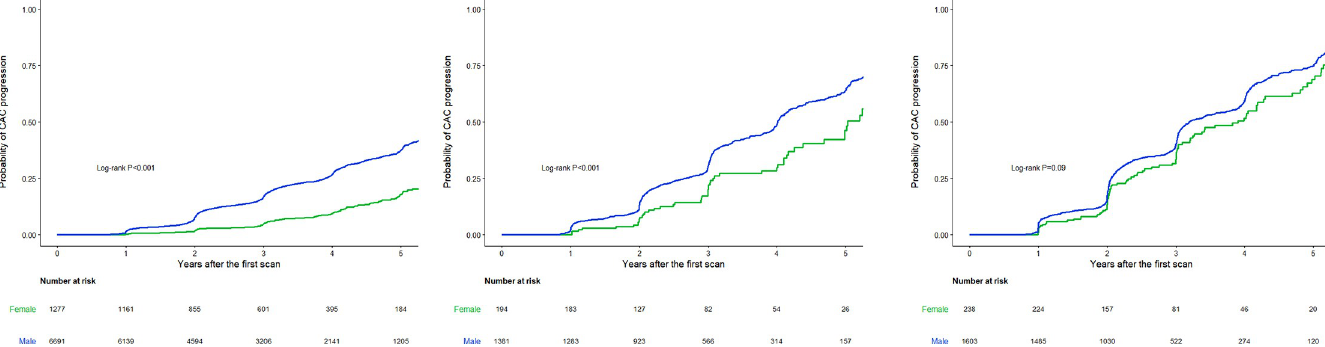
Fig 4. Kaplan-Meier 5-year CAC progression for men versus women according to the 10-year ASCVD risk score. (A) 10-year ASCVD risk < 5%, (B) 5% � 10-year ASCVD risk < 7.5%, (C) 10-year ASCVD risk � 7.5%. CAC, coronary artery calcium; ASCVD, atherosclerotic cardiovascular disease.